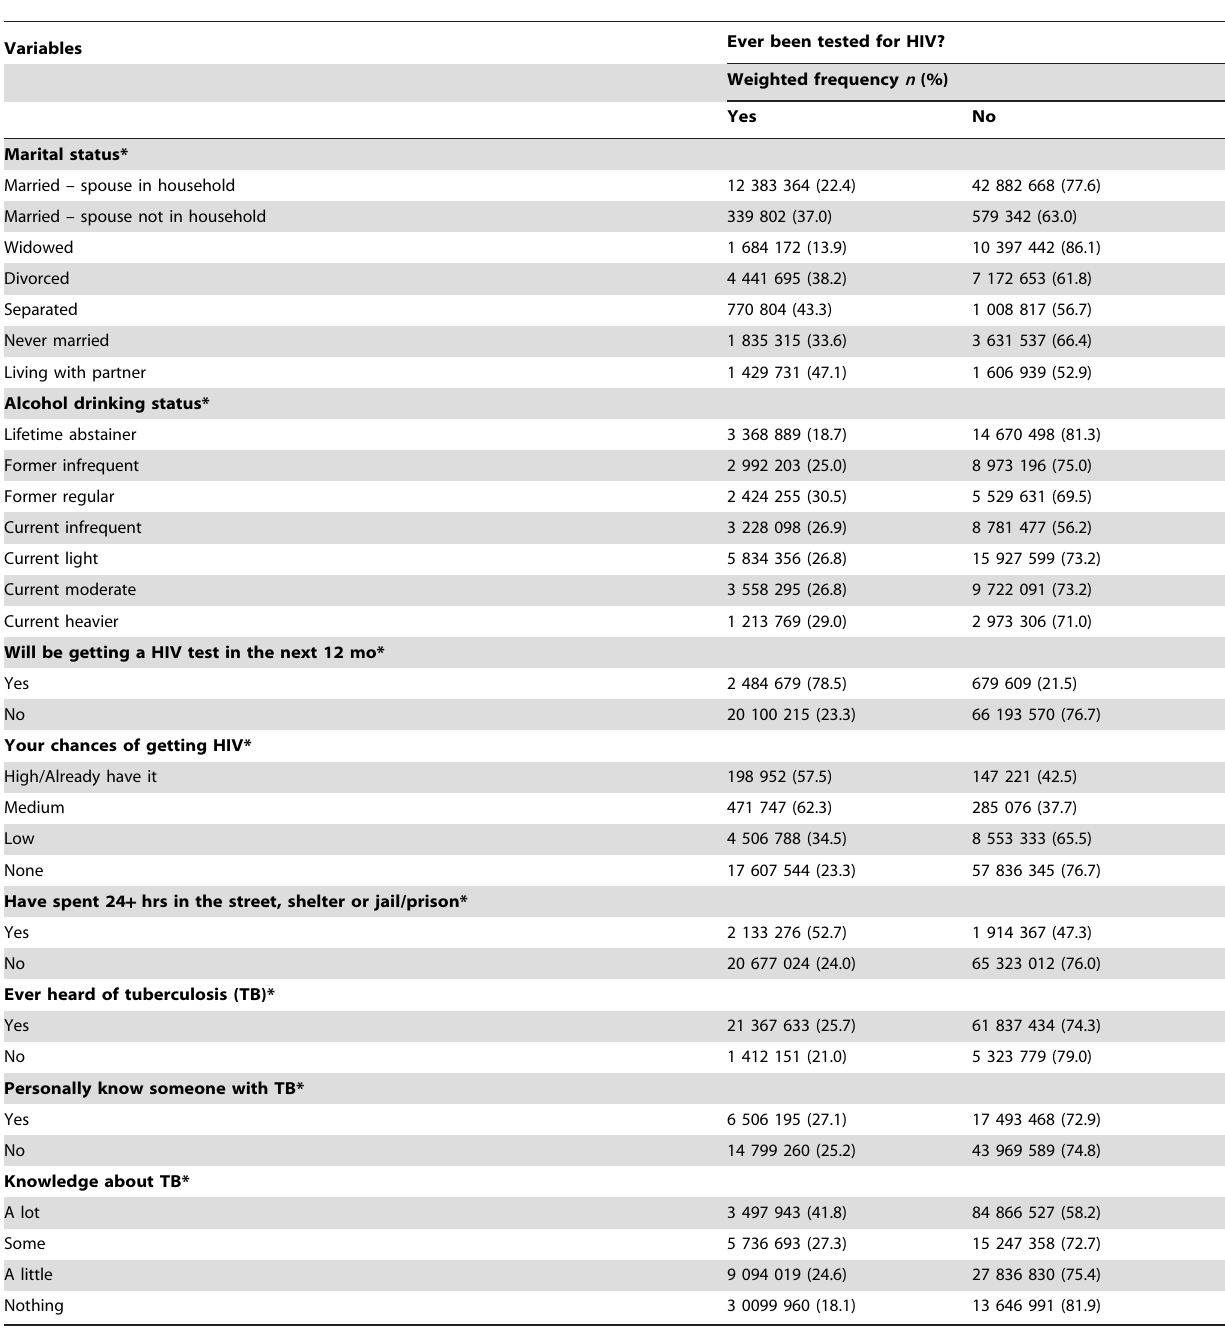
Table 3. Respondent’s lifestyle, knowledge of HIV-related disease and associations with HIV